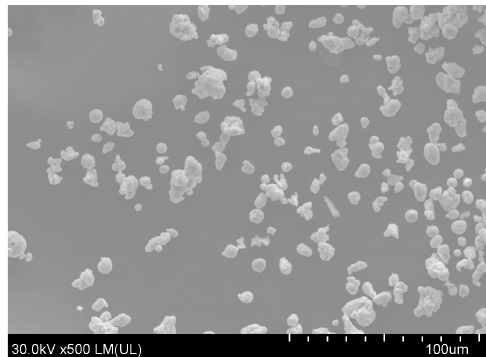
Figure 1. SEM image of copper particles used as a filler.